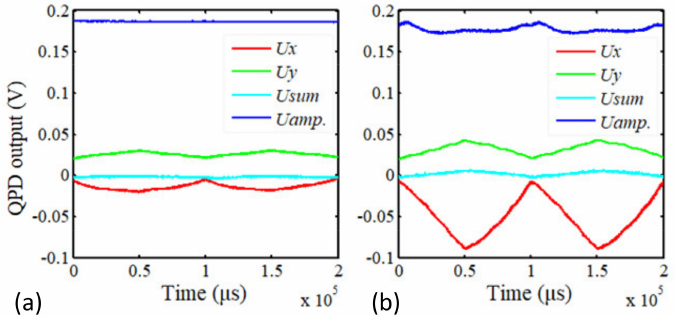
Figure 11. Laser tracking errors caused by the movement of the Y-scanner ( a ) and the Z-scanner ( b